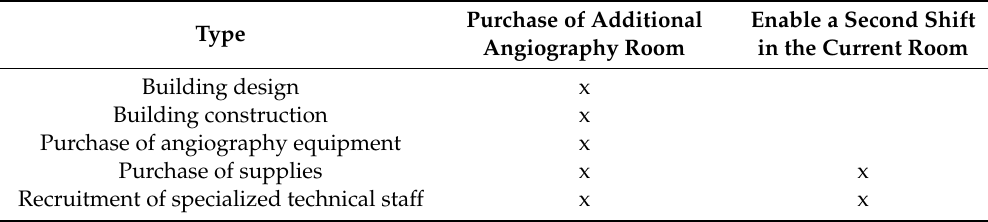
Table 5. Types of expenses to be considered in each proposed improvement